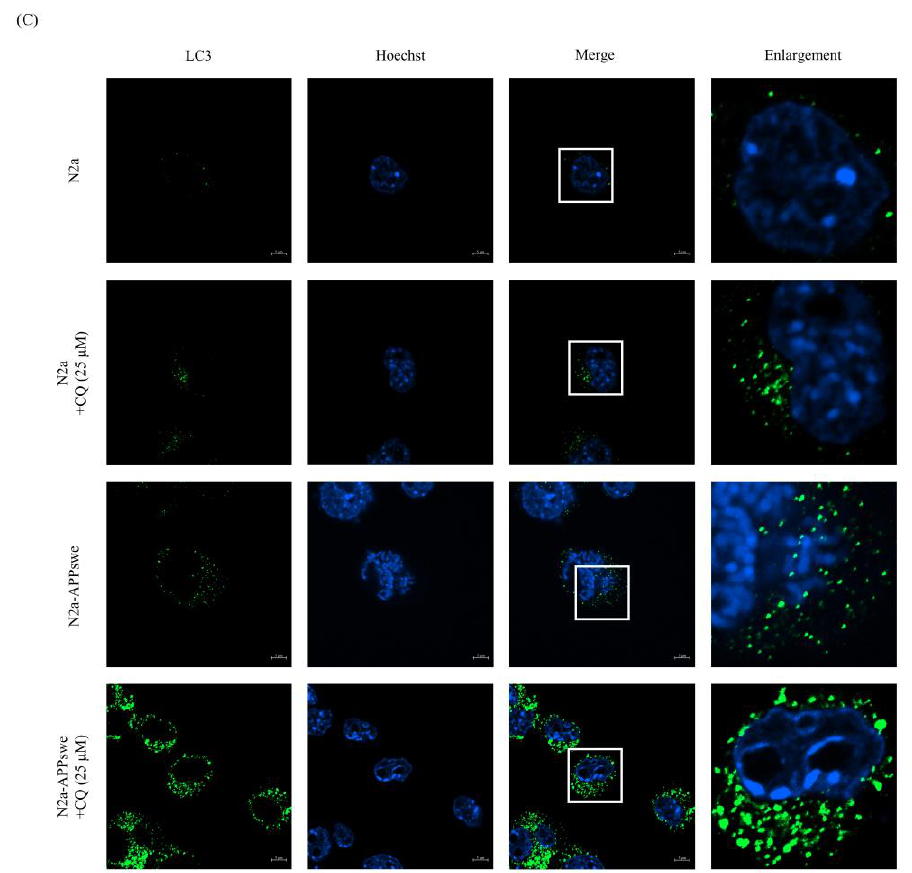
Figure 2. Autophagy was increased by APP Swedish mutation in N2a-APPswe cells. ( A ) Western blot analysis of ATG5, ATG7, Beclin-1, Lc3, and p62 expression in N2a-APPswe cells cultured for 6, 12, and 24 h. ( B ) Lc3 and p62 protein expression was determined by Western blot analysis using N2a-APPswe cells cultured for 24 h in the presence or absence of chloroquine (CQ) (25 µ M) treatment for 24 h. ( C ) Confocal microscopy analysis of Lc3 puncta in N2a and N2a-APPswe cells cultured for 24 h in the presence or absence of CQ (25 µ M) treatment for 24 h. Data are represented as the means ± SEMs of three independent experiments (* p < 0.05, ** p < 0.01, and *** p < 0.001).